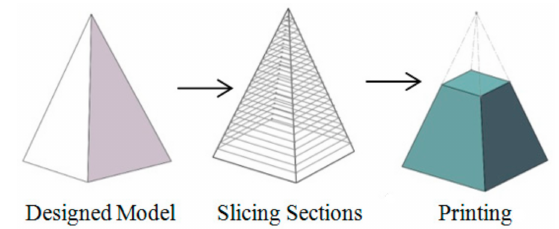
Figure 1. Schematic of 3D printing [8].